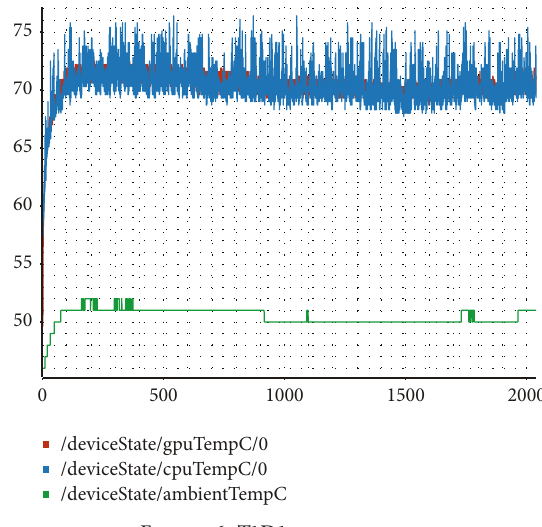
Figure 6: T1D1 temperatures.